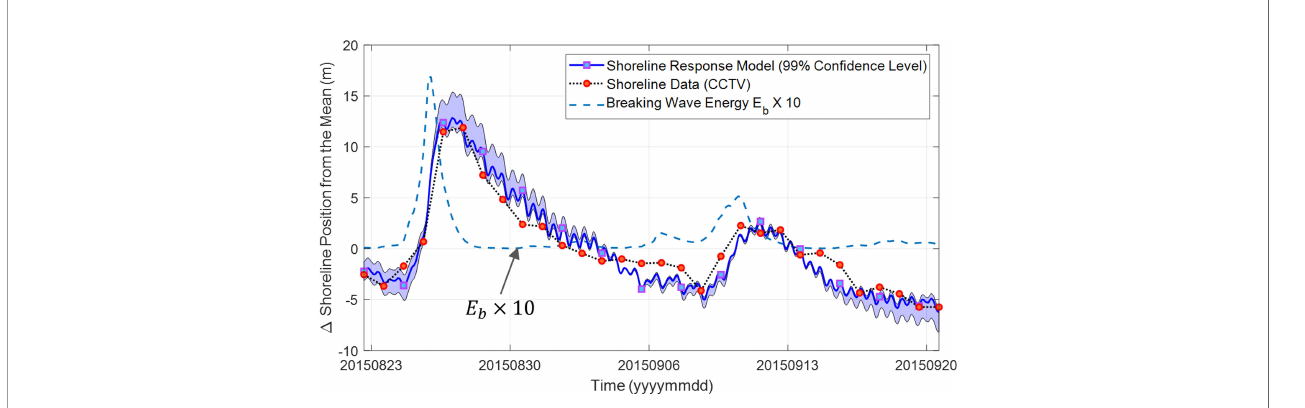
FIGURE 9 | Comparison with shoreline data extracted from CCTV image and model results of SLRM applying the beach recovery and response factors of